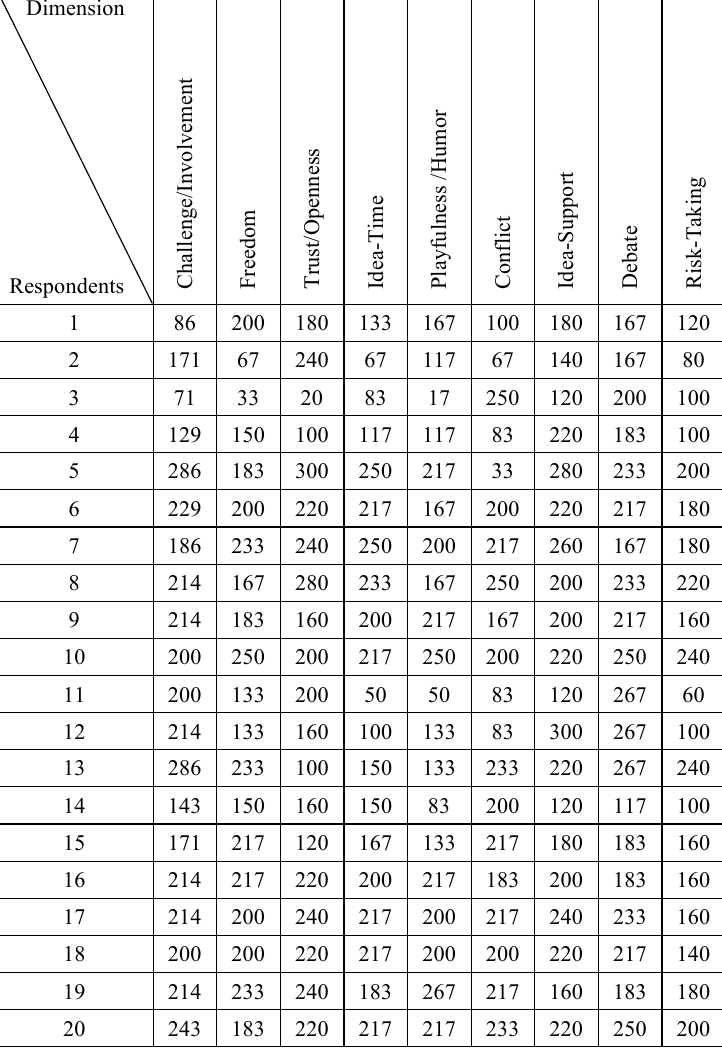
Table 1. Assessment of the technological innovation climate dimensions by each respondent